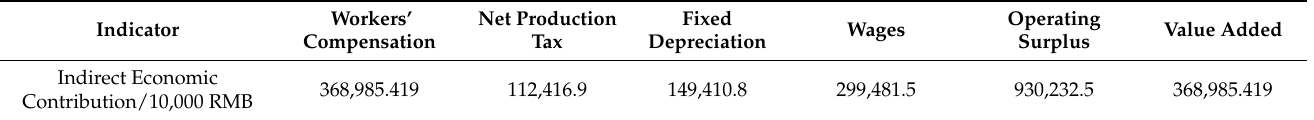
Table 4. Indirect economic contribution of Xiamen Port to the city in 2017.